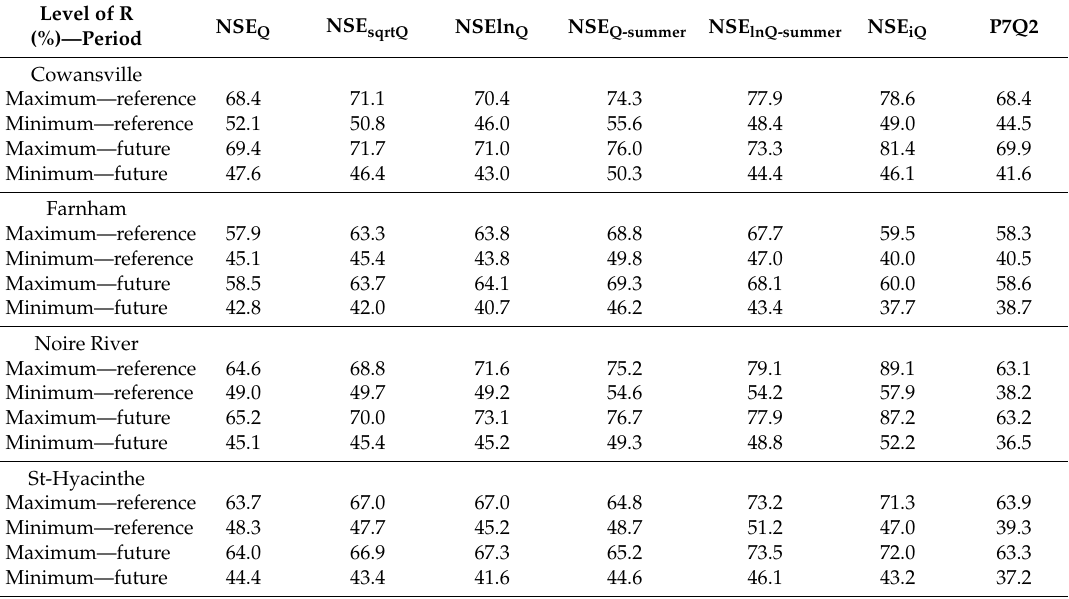
Table 4. Variation of the levels of the soil reservoir R for the GR4J